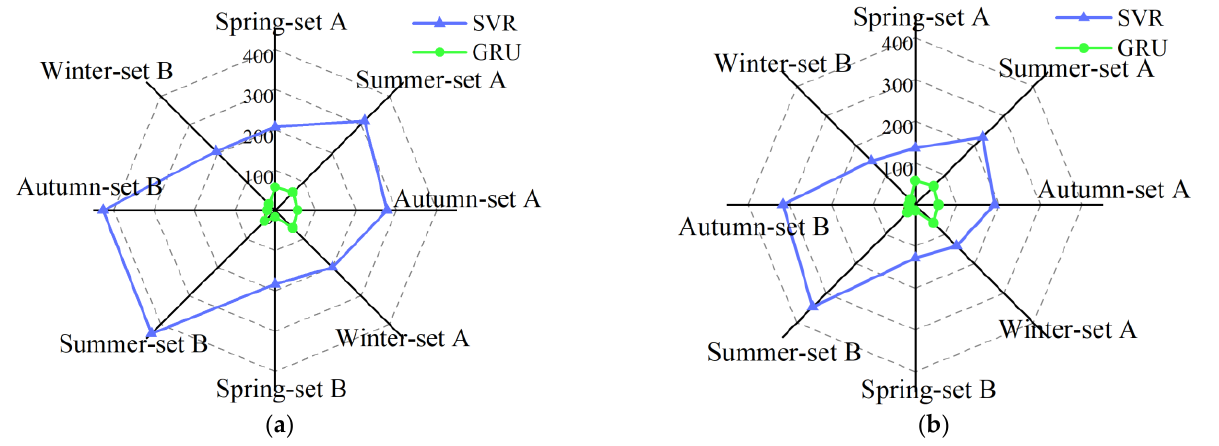
Figure 8. RMSE and MAE of model: ( a ) RMSE; ( b ) MAE.